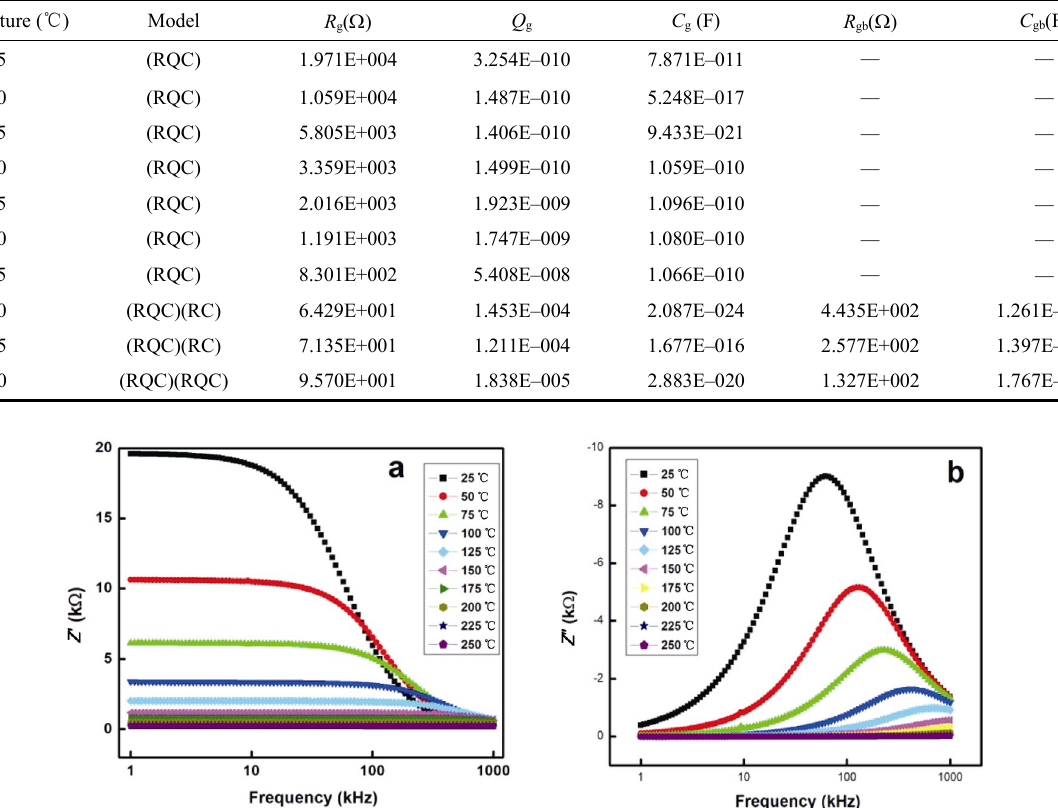
Table 2 Comparison of calculated values of grain resistance ( R g ), grain boundary resistance ( R gb ), grain capacitance ( C g ), grain boundary capacitance C gb , and constant phase factor ( Q g , Q gb ) at some selected temperatures